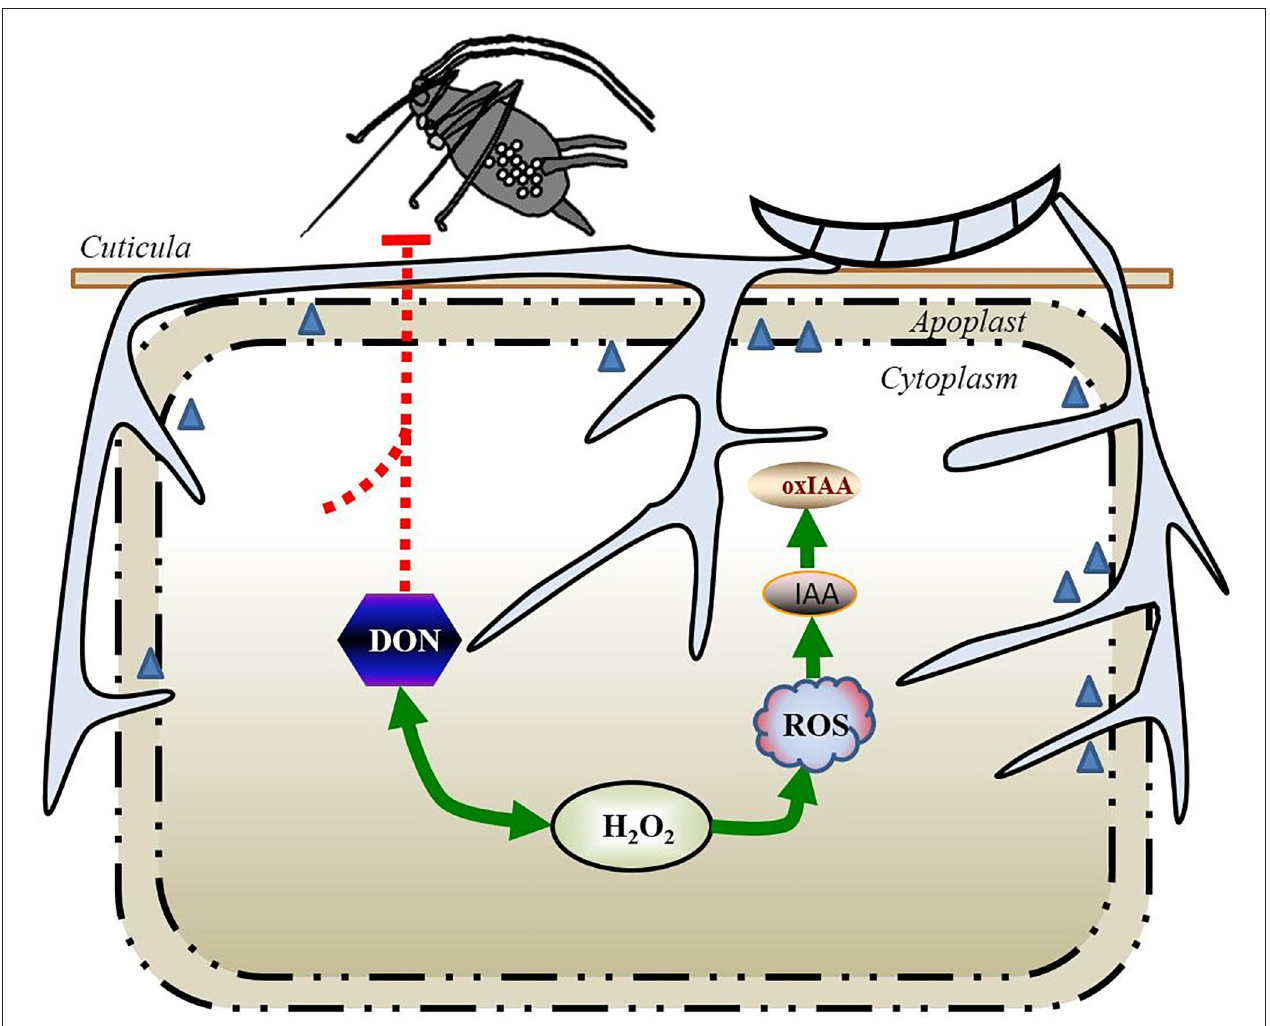
FIGURE 4 | Model summarizing the tripartite interaction S. avenae –cereal– F. graminearum during the more invasive intracellular infection (necrotrophic phase) in wheat. The accumulation of DON becomes apparent and is necessary for the spread of the fungus in the rachis of wheat, and the whole spike becomes symptomatic, which results in a rapid decrease in the aphid populations. The rapid and transient generation of H 2 O 2 induced by S. avenae and F. graminearum could significantly elevate the expression of the DON biosynthesis machine, while the DON production led to a further increase in ROS content. The extensive increase in the ROS content in host plants facilitates the oxidation of IAA to oxIAA and inactivates auxin-dependent responses. DON, deoxynivalenol; H 2 O 2 , hydrogen peroxide; IAA, indole-3-acetic acid; oxIAA, 2-oxindole-3-acetic acid; ROS, reactive oxygen